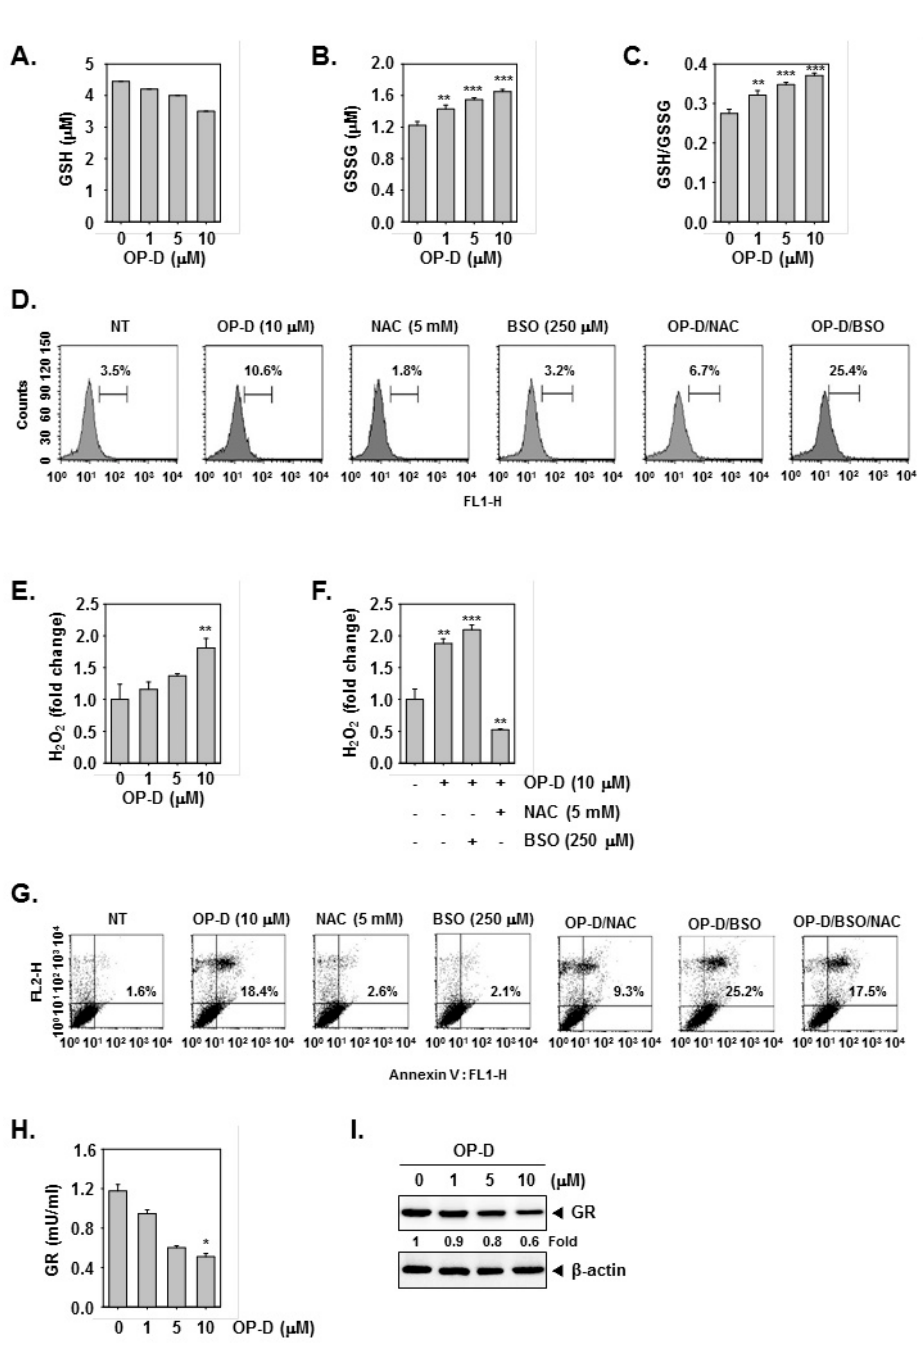
Figure 5. GSH/GSSG imbalance mediates the OP-D-induced ROS production. ( A – C ) A549 cells were treated with indicated concentrations of OP-D for 24 h, and then assayed for GSH, GSSG, and GSSG/GSH. ( D ) A549 cells were exposed to NAC (5 mM) with or without buthionine sulfoximine (BSO) (250 µM) for 30 min, and then treated with OP-D (10 µM) for 24 h. The cells were incubated at 37 °C with H 2 DCF-DA for 30 min and analyzed using flow cytometry. ( E ) A549 cells were treated as described in panel A – C and then subjected to assay for H 2 O 2 analysis. ( F ) A549 cells were treated as described in panel D and then subjected to assay for H 2 O 2 analysis. ( G ) A549 cells were treated as described in panel D, harvested, stained with FITC-conjugated anti-Annexin V, and analyzed using a flow cytometer. ( H ) A549 cells were treated with the indicated concentrations of OP-D for 24 h, and then collected for investigation using a cellular GR assay kit. ( I ) A549 cells were treated with the indicated concentrations of OP-D for 24 h and Western blotting was performed. Data represent the mean of three measurements ± S.D., * p < 0.05; ** p < 0.01; *** p <